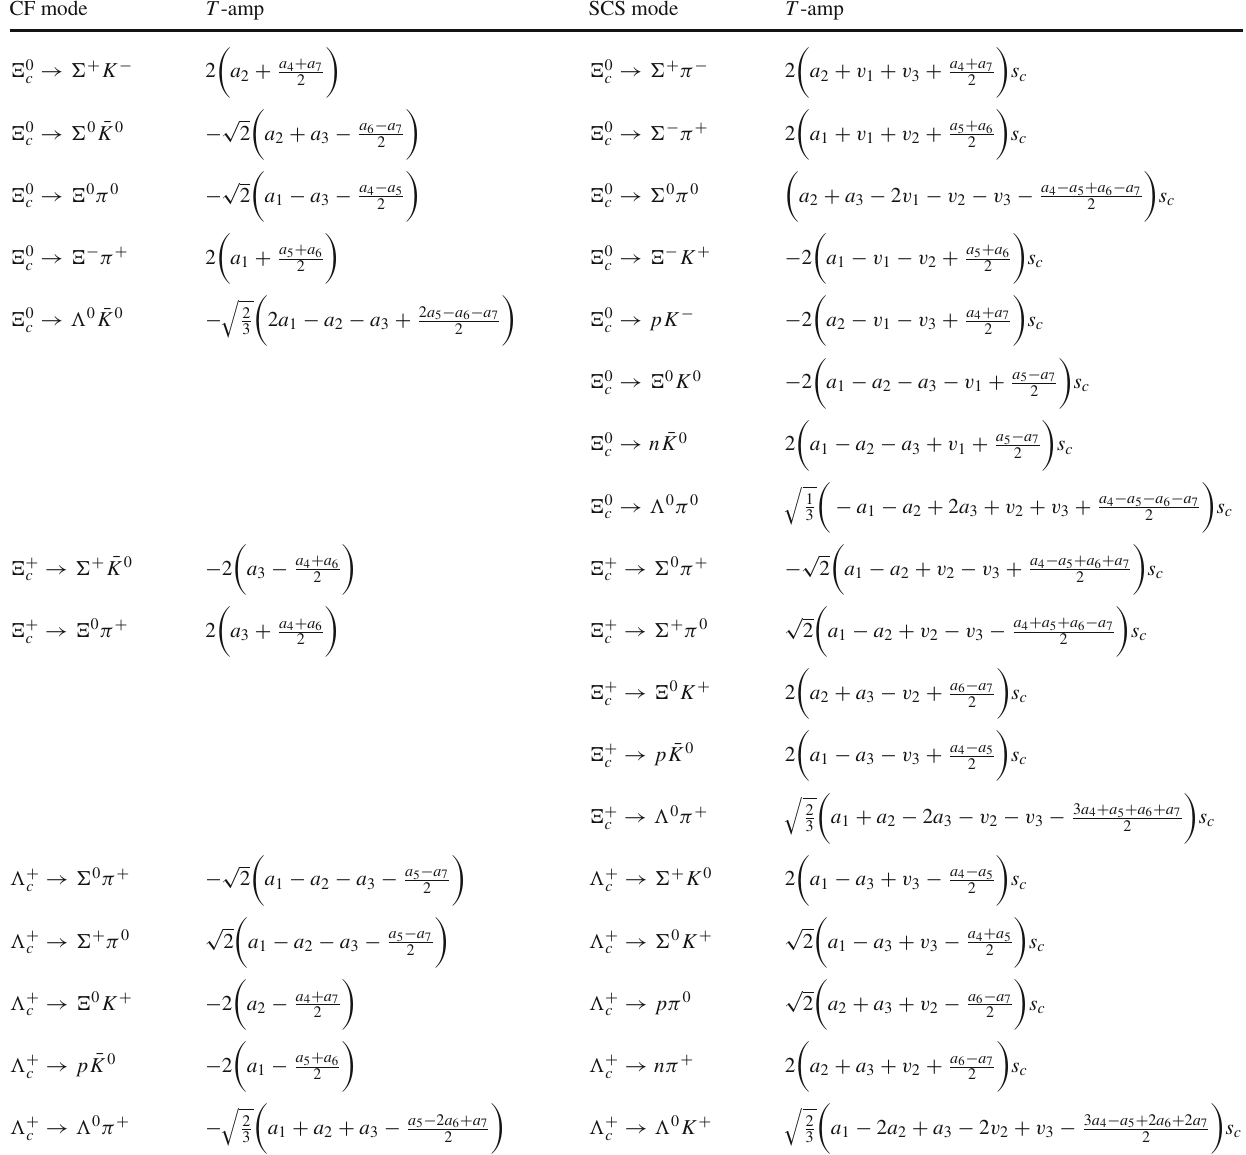
Table 1 Amplitudes of T ( B c → B n M ) , where T -amps refers to T ( B c → B n M ) and CF (SCS) represents Cabbibo favored (singly Cabbibo- suppressed) CF